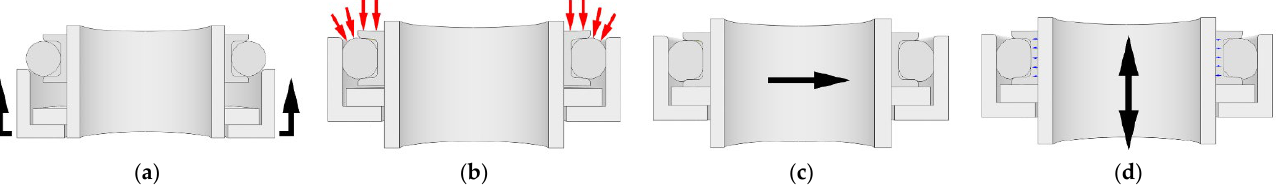
Figure 8. Analysis steps of the Cap-seal. ( a ) Pre-compression; ( b ) Pressurization; ( c ) Offset; ( d ) Wear.